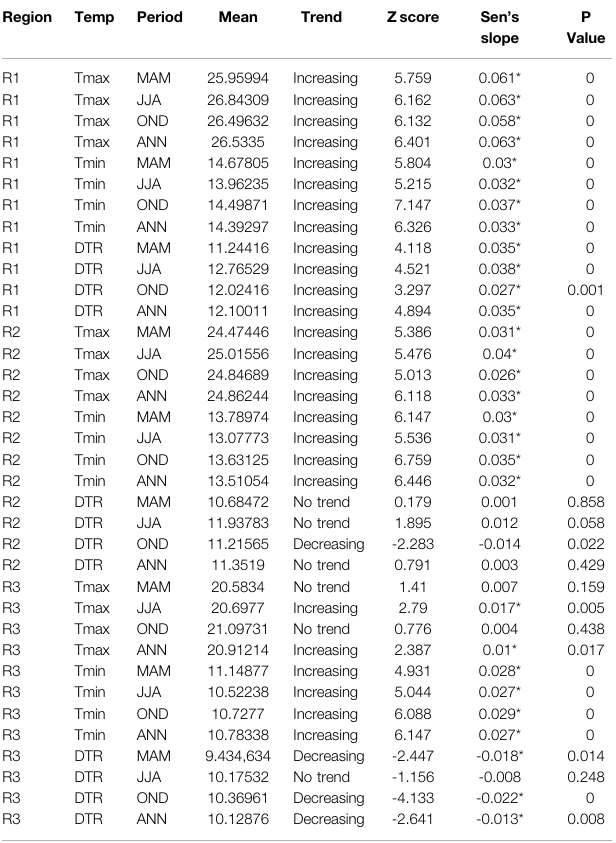
TABLE 2 | Annual and Seasonal Trends ( ° C/decade) from 1961 to 2014 for minimum, maximum and DTR for R1, R2 and R3 at 95% con fi dence level. Region Temp